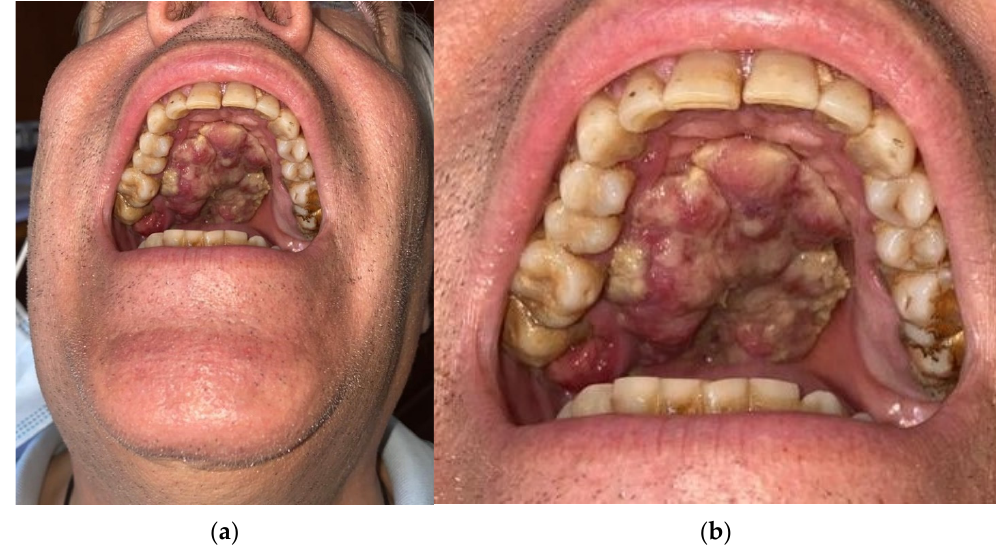
Figure 1. Clinical photo showing the intraoral aspect of the lesion. No extraoral swelling is present ( a ). Detail of clinical photo, revealing exophytic and ulcerated lesion with irregular aspect starting from the hard palate, 5 × 4 cm sized ( b ).